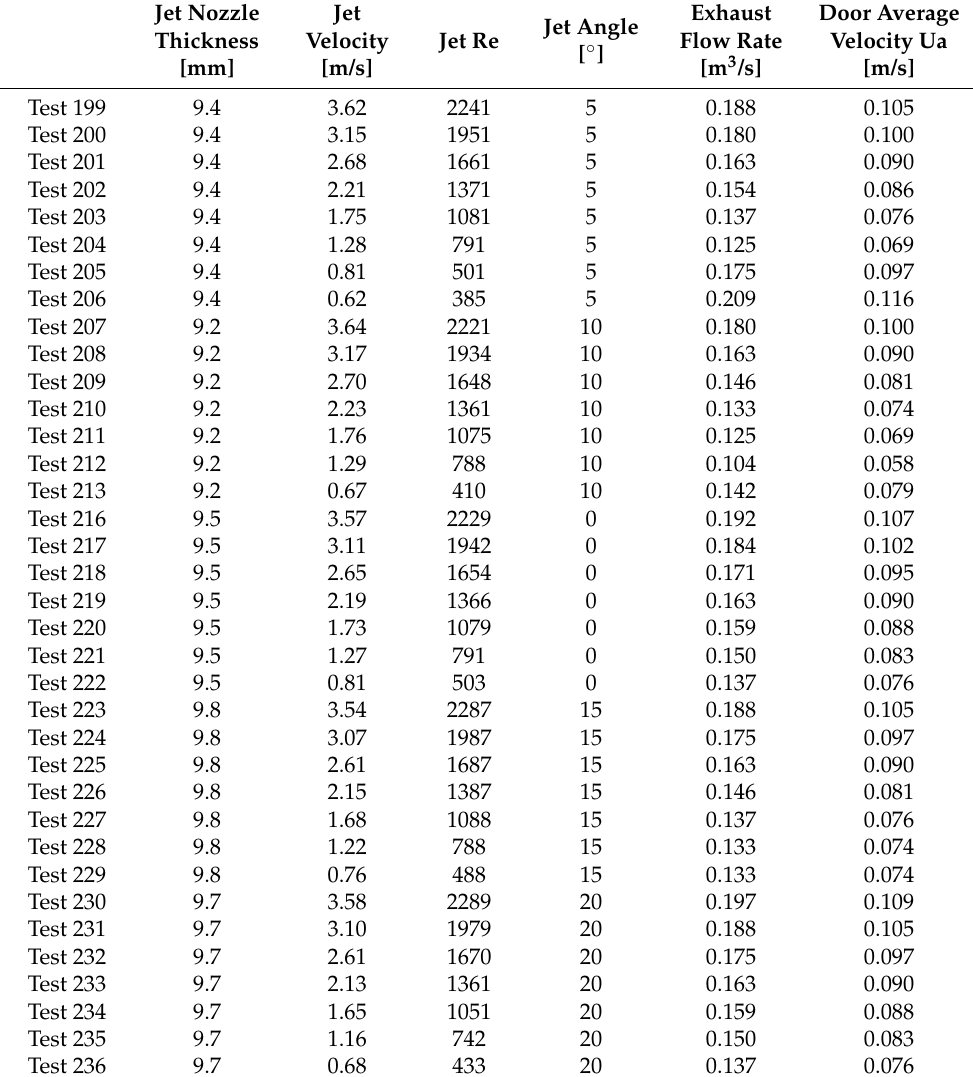
Table 2. Conditions of the tests for the 10 mm nominal thickness of the jet